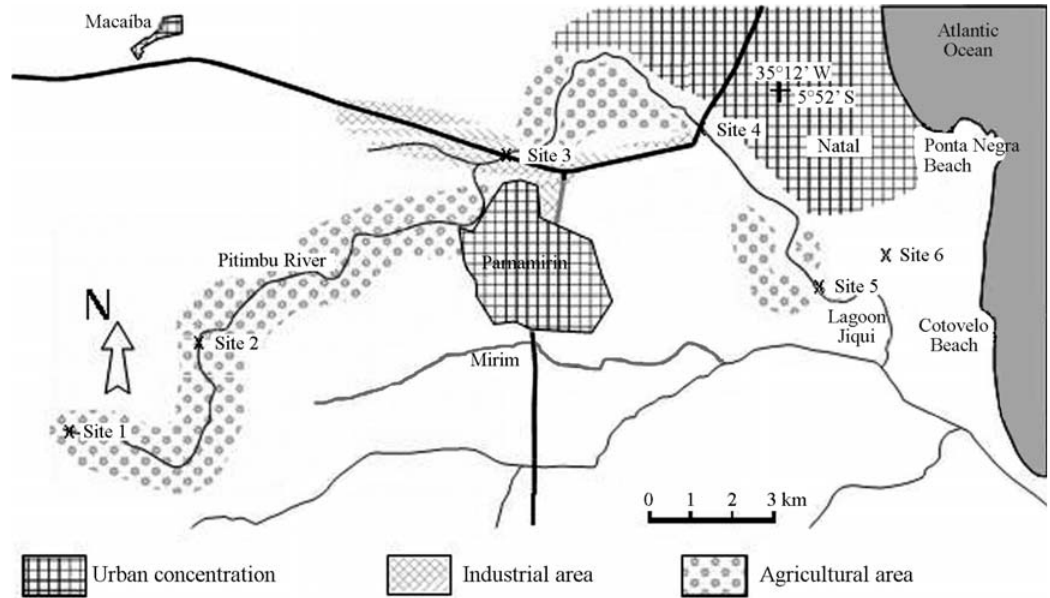
Figure 1 - Sampling sites in the Pitimbu River, Rio Grande do Norte, northeastern